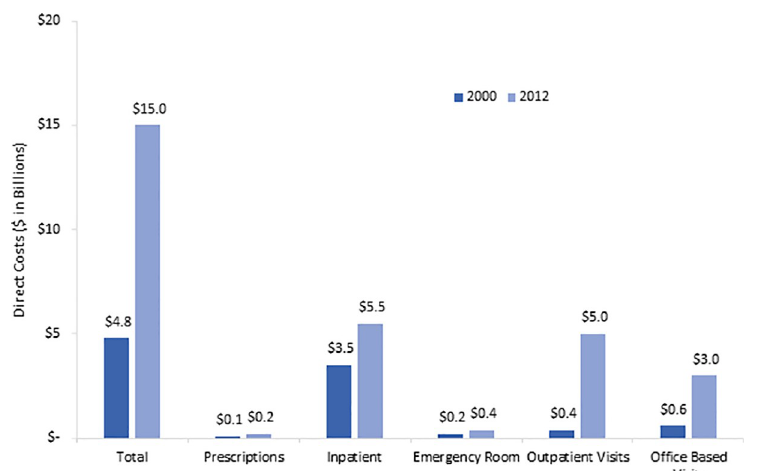
Fig 2. Total U.S. direct expenditures for SSTIs by healthcare service, 2000 and